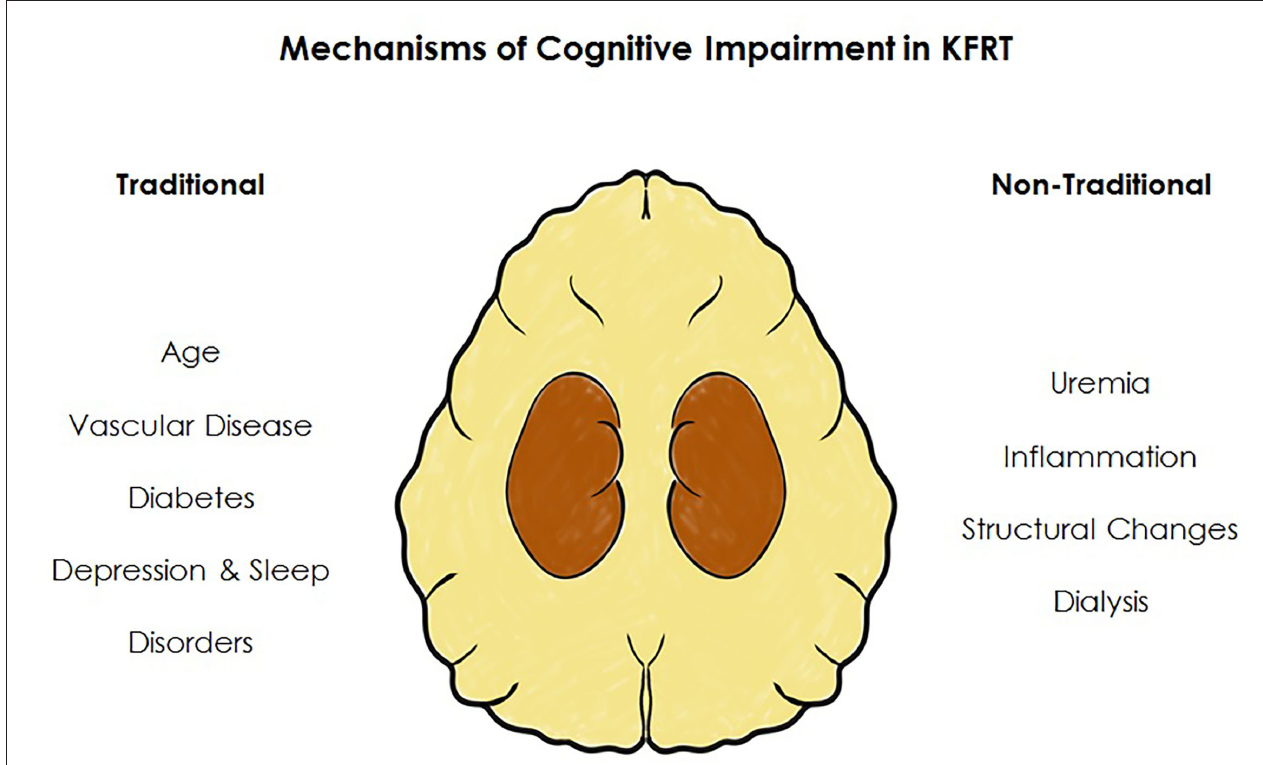
FIGURE 5 | Factors associated with cognitive impairment in kidney failure. In addition to an increased burden of risk factors traditionally associated with cognitive impairment, those receiving KRT have additional factors unique to KFRT.